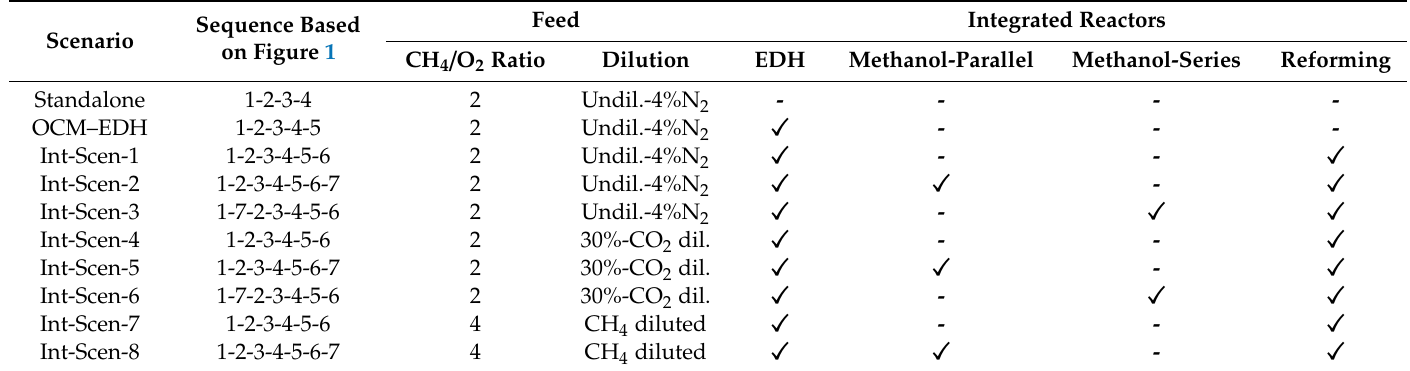
Table 3. List of selected simulated process scenarios and their